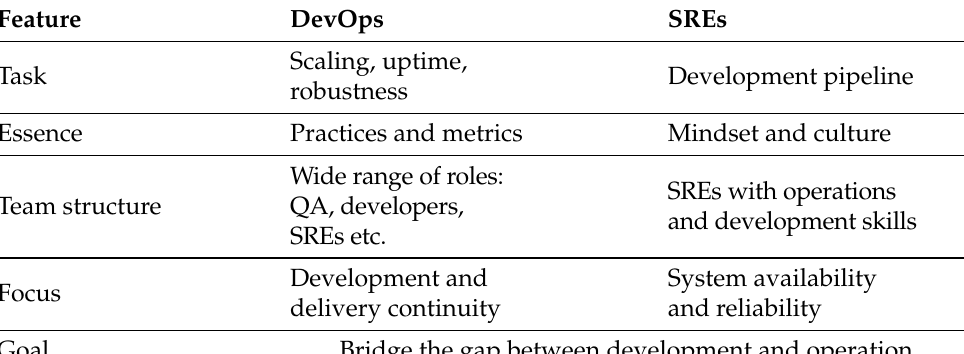
Table 2. The differences between the DevOps and SREs